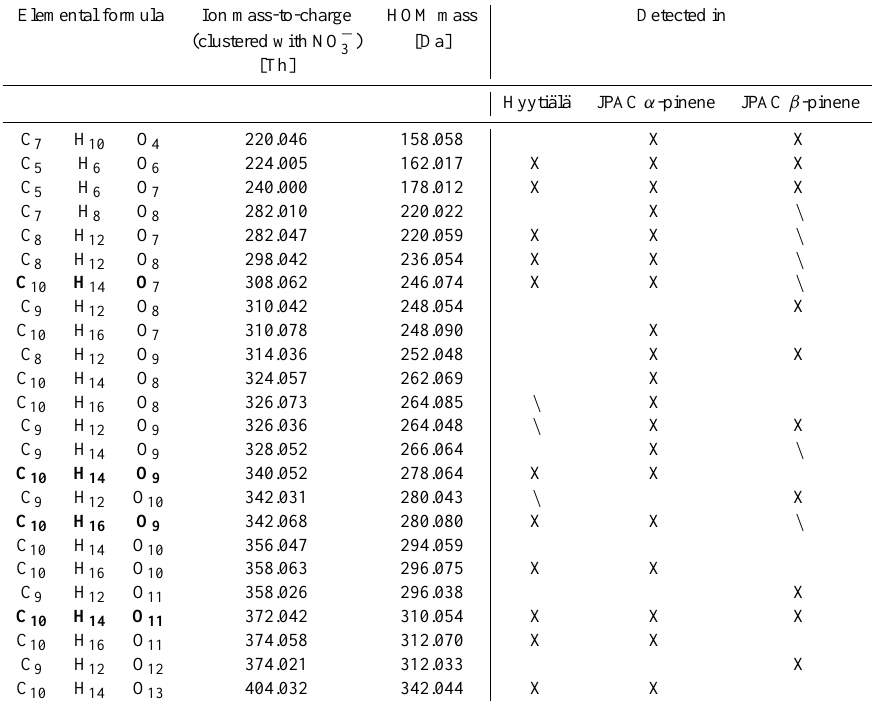
Table A1. List of observed monomers detected in Hyyti¨al¨a and JPAC. An “X” means that the identification is fairly unambiguous, a blank means that the ion has not been detected, and “/” means that the ion might be present, but could not be identified due to insufficient signal or overlapping peaks from other compounds.